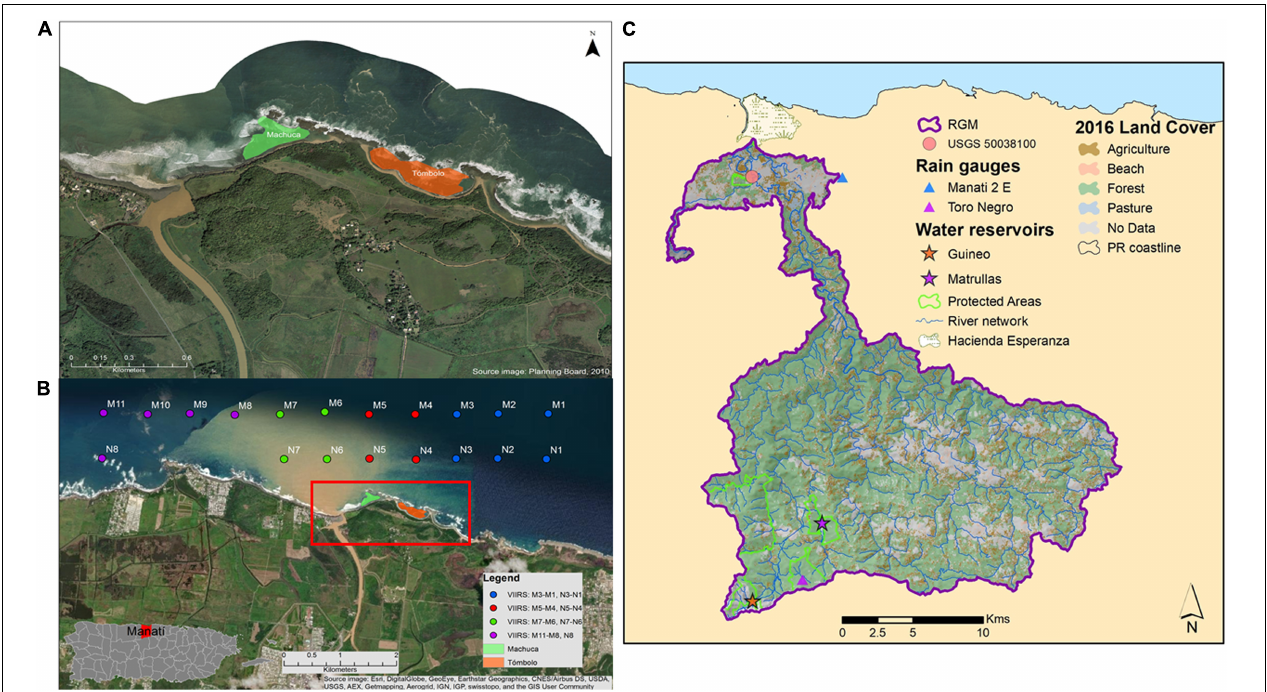
FIGURE 1 | (A) Worldview image (provided by the PR Planning Board) showing the location of the Machuca and Tómbolo Reefs (green and orange polygons, respectively) in reference to the RGM outlet in north coast, Puerto Rico. (B) Worldview image from a November 2014 rainfall event showing the extent of the river plume. The centers for each VIIRS virtual station (750 m pixel size) (N1–N8: nearshore; M1–M11: mid-platform) are superimposed. A map of Puerto Rico showing the location of the municipality of Manatí on the north coast is included for reference. An oceanic station (O1; not shown here) located approximately 25 Km north of the study sites was used as a reference for oligotrophic waters (Case 1) (see section “Satellite-Based Water Quality Parameters”). (C) 2016 RGM watershed map with major land cover classes. Only two reservoirs (Guineo and Matrullas) are located within the watershed boundaries. The Hacienda La Esperanza Reserve on the northern part of the watershed is also shown as well as the location of the USGS streamflow station (50038100).